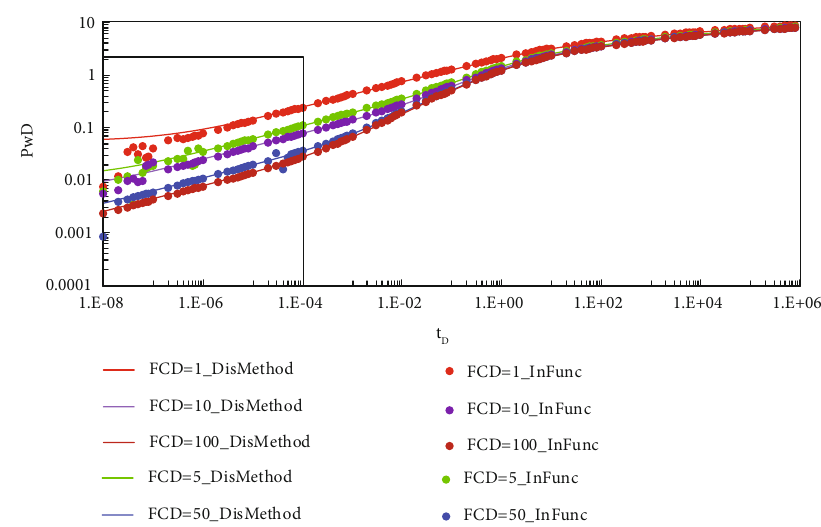
Figure 7: The Riley method causes errors when the time is small.